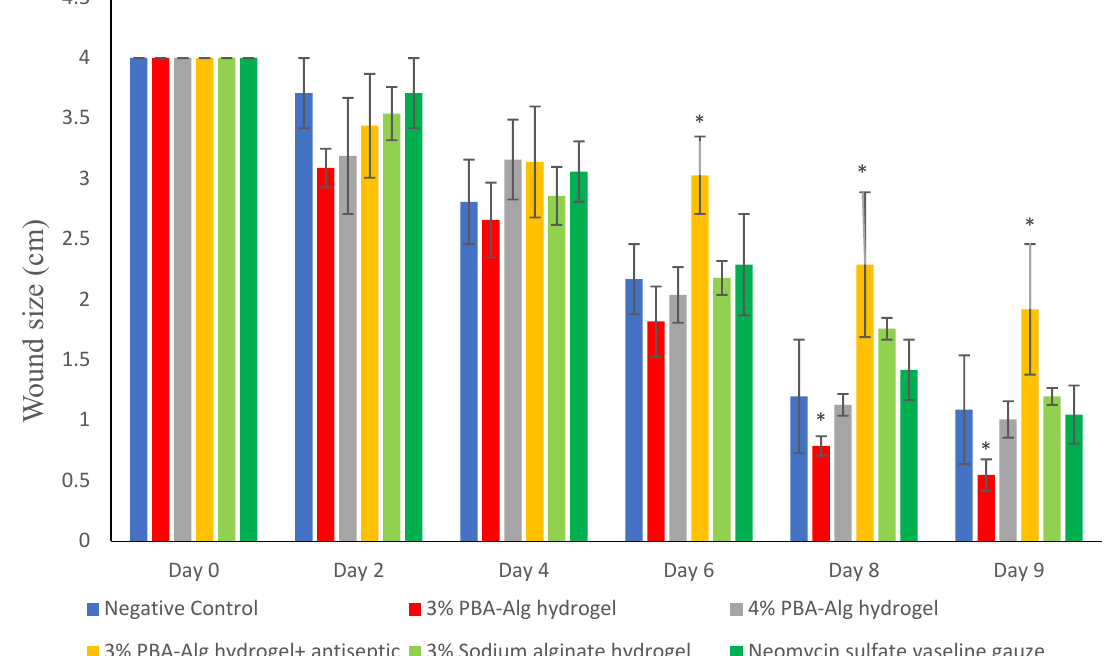
Figure 2. Wound size profile obtained in animal groups after various treatments. N = 5 groups of 5 rats per treatment and control. Treatments: 3% PBA-Alg hydrogel, 4% PBA-Alg hydrogel, 3% PBA-Alg hydrogel + antiseptic. Values are presented as mean ± standard deviation. Data were analyzed using one-way analysis of variance (ANOVA). Significant difference at * p < 0.05 with 3% PBA-Alg hydrogels showing significantly smaller wound size compared to other treat- ments.